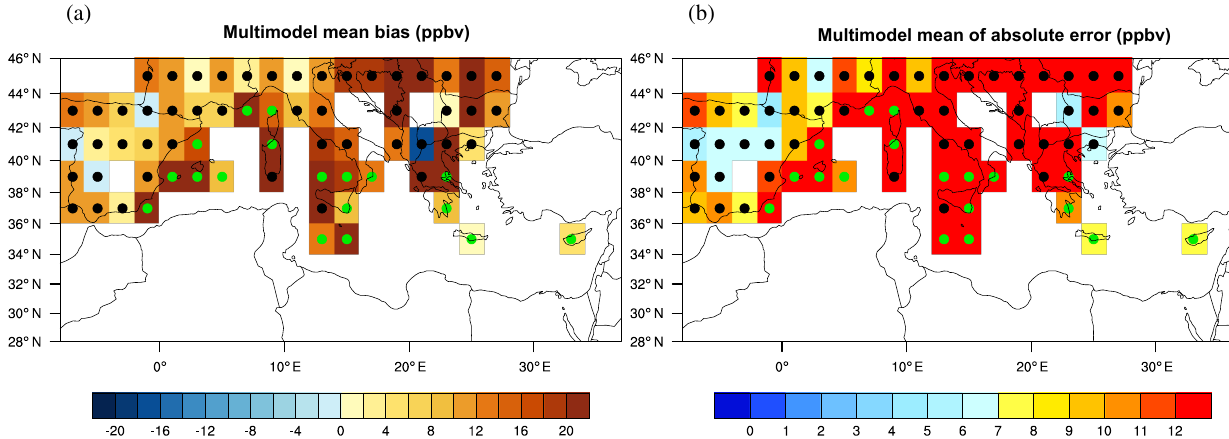
Figure 4. ACCMIP ensemble mean bias of surface ozone concentration in ppbv (a) and the ACCMIP ensemble mean error in ppbv (b) over the REF period (2000 time slice) from the historical experiment over the Mediterranean Basin. Black and green filled circles represent land and sea, respectively. Brown colors represent positive values of mean bias for panel (a) and red colors represent relatively large absolute error for panel (b) . Blue colors represent negative values of mean bias for panel (a) and relatively small absolute error for panel (b).